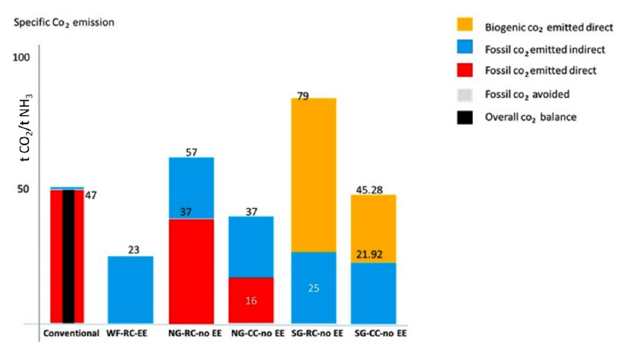
46.7% for WF-RC-EE [69,77–79].